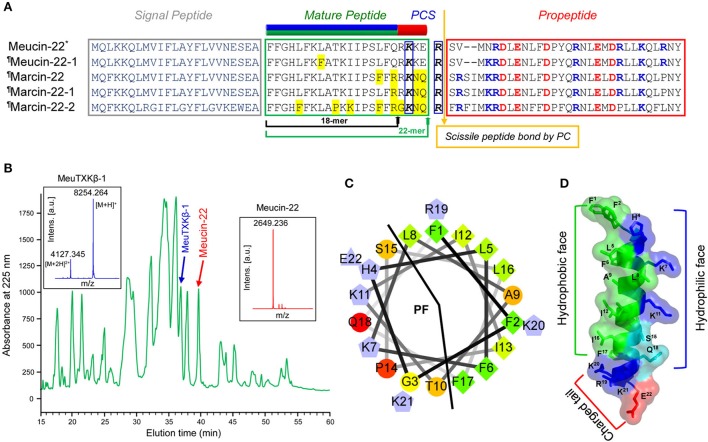
Meucin-22 and homologs. (A) Precursor amino acid sequences. The green arrow indicates a newly proposed cleavage site based on the presence of a putative proprotein convertase signal (PCS), which leads to a C-terminal extension of four residues relative to the initially proposed Meucin-18, indicated by a black arrow. In the mature region, the amino acids non-identical to Meucin-22 are shadowed in yellow and in the proregion, charged residues are colored (basic, blue; acidic, red). The secondary structures of Meucin-22 and its homologs comprising an N-terminal amphipathic domain (residues 1–18, green and blue) and a charged tail (residues 19–22, red) are showed at the top of the sequence alignment. (B) Isolation of native Meucin-22, along with MeuTXKβ-1 from the venom of M. eupeus by RP-HPLC. Inset, MALDI-TOF MS of Meucin-22 and MeuTXKβ-1. For the spectrum of the latter, there are two main peaks, corresponding to the singly and doubly protonated forms of this peptide. (C) Helical wheel projection of Meucin-22. Color codes of amino acids are identical to those of Figure 2C. (D) Ribbon representation of Meucin-22 backbone structure that was built based on the experimental structure of racemic Ala-(8,13,18) Magainin 2 (pdb 4MGP), an analog of frog skin AMP. Residues with different side-chain natures are indicated in different colors (blue, positively charged; red, negatively charged; green, hydrophobic; cyan, polar) on the background of a semitransparent surface. In the helix formed by the N-terminal 18 residues, all hydrophobic residues are located on one surface while cationic and hydrophilic residues on another surface.The figure was prepared with PyMOL (http://www.pymol.org).